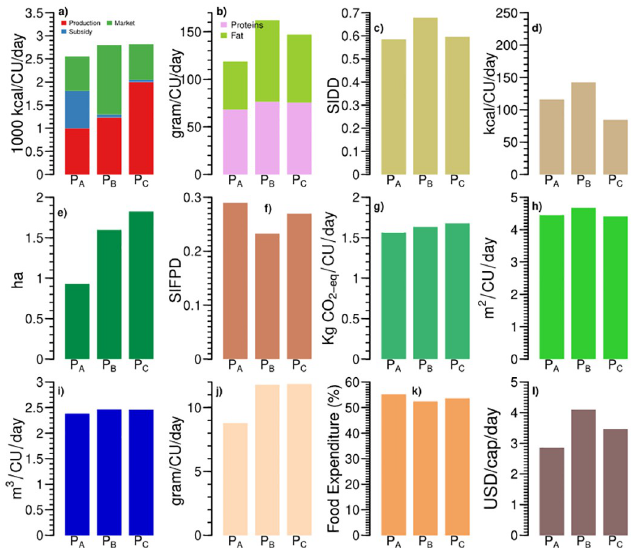
Fig 2. Three production-based food systems (P (a) sources of calorie intake, (b) protein and fat intake; (c) Simpsons Index of Dietary Diversity (SIDD), (d) processed and ready to eat food intake, (e) land cultivated (ha), (f) Simpsons Index of Food Production Diversity (SIFPD), (g) greenhouse gas emissions, (h) land footprint, (i) water footprint, (j) animal protein intake, (k) share of food expenditure, and (l) daily Per capita